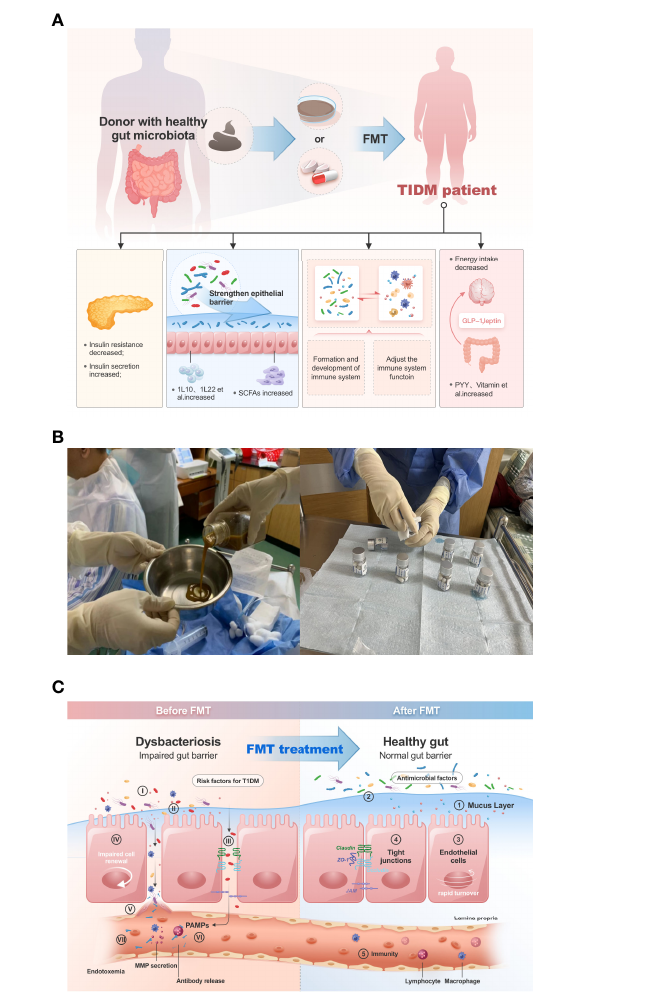
FIGURE 1 (A) FMT can improve the disease progression of T1DM patients in several ways. (B) , in our clinical trial study, patients were given gut microbiota transplantation by injection of bacterial solution and oral capsules (Clinical Registration Number: ChiCTR2100045789, Chinese Clinical